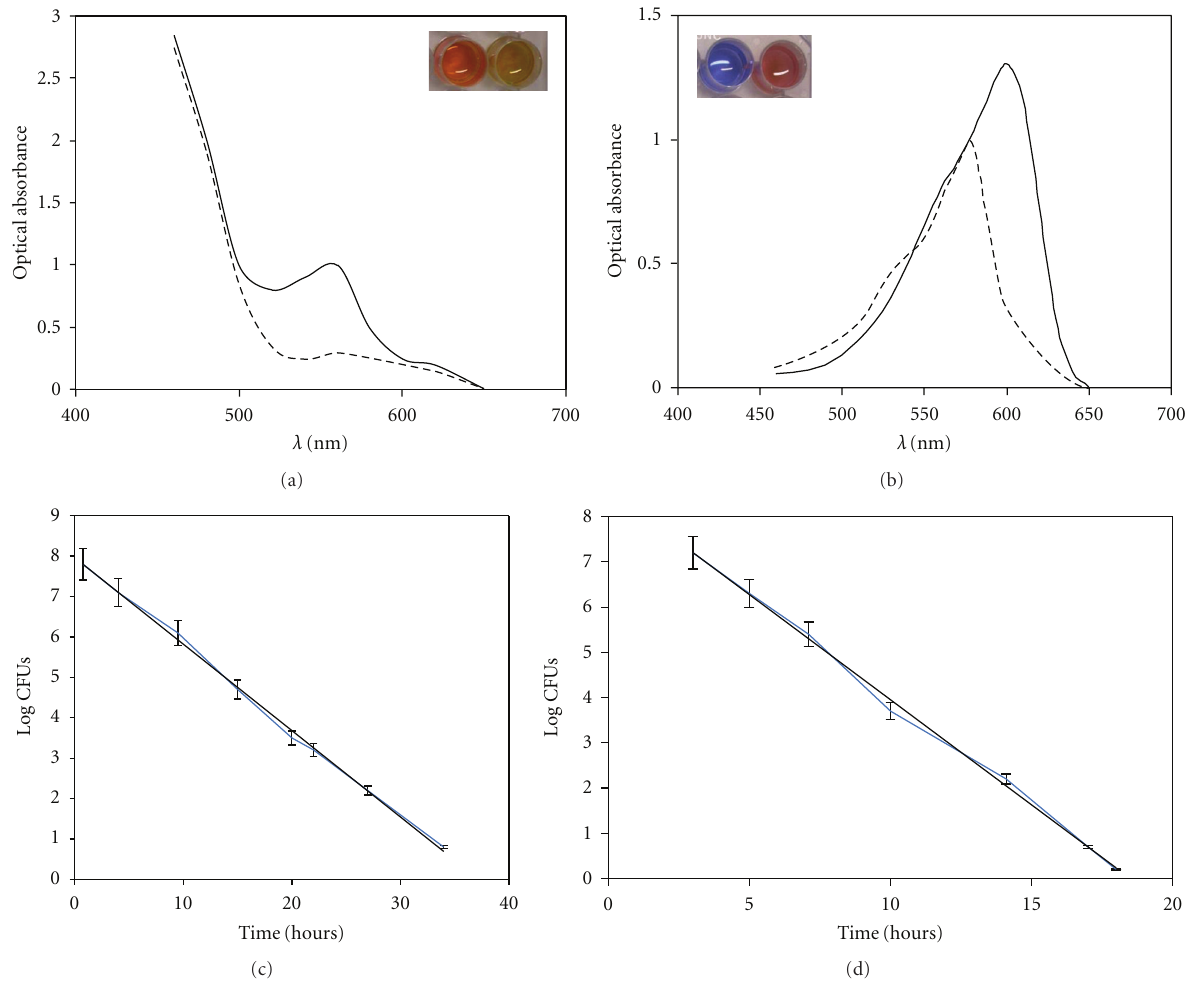
Figure 1: Color switch of BTA reagents and BTA correlation lines, (a)-(b) optical absorbance expressed as optical density versus the wave length in the visible region for BT-PR (a) and BT-RZ (b) reagents. Solid line: optical absorbance of BTA reagent before the switch; dotted line: optical absorbance of BTA reagent after the switch. Inserts: (a) BT-PR reagent color before (left) and after (right) the switch (red and yellow, resp.); (b) BT-RZ reagent color before (left) and after (right) the switch (blue and pink, resp.). (c)-(d) correlation lines correlate the time (hours) for color switch of BT-PR (c) and BT-RZ (d) reagents and log of the initial number N 0 of planktonic Streptococcus mutans ATCC 25175 T (c) and Pseudomonas aeruginosa ATCC 15692 (d). Correlation lines were described by the following linear equations: y = − 0.21 32 x + 7.9597 and r 2 = 0.9899 for S. mutans (c) and y = − 0.4675 x + 8.5421 and r 2 = 0.9968 for P. aeruginosa (d).